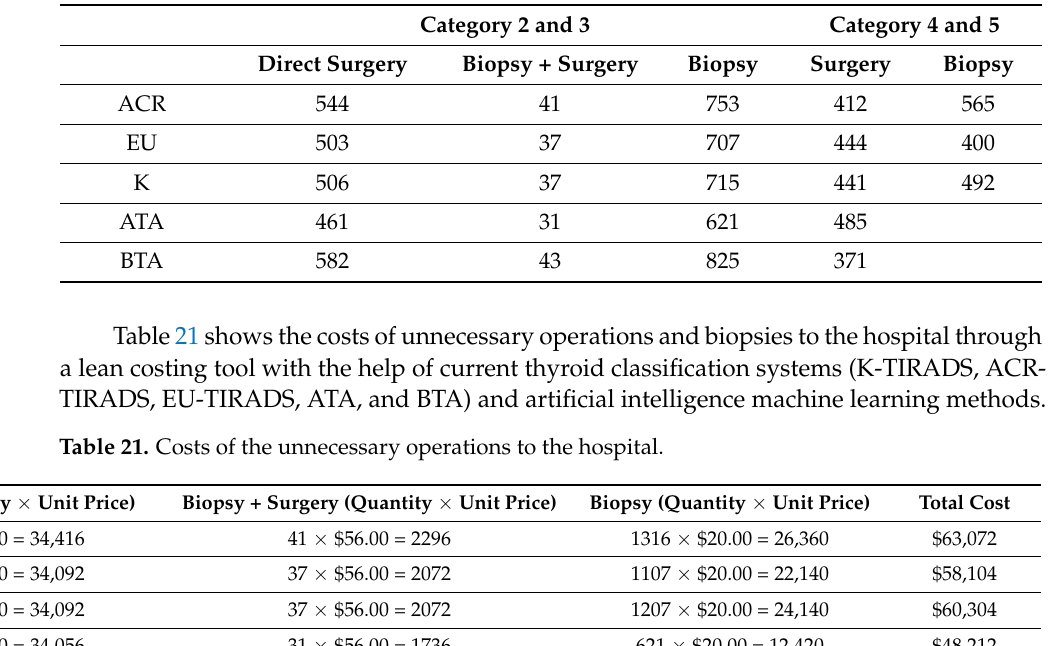
Table 20. Unnecessary operations and FNA biopsies by the classification systems.